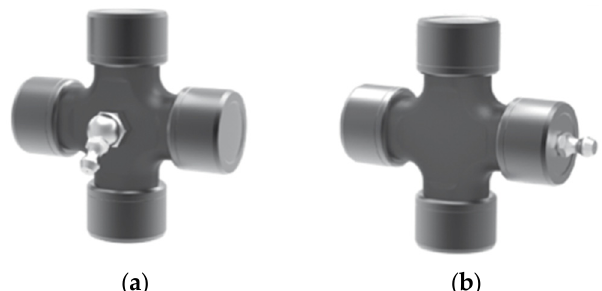
Figure 7. Positioning of grease zerk. ( a ) Centered in cross kit; ( b ) Assembled in the bearing cap on one arm of the cross kit [27].